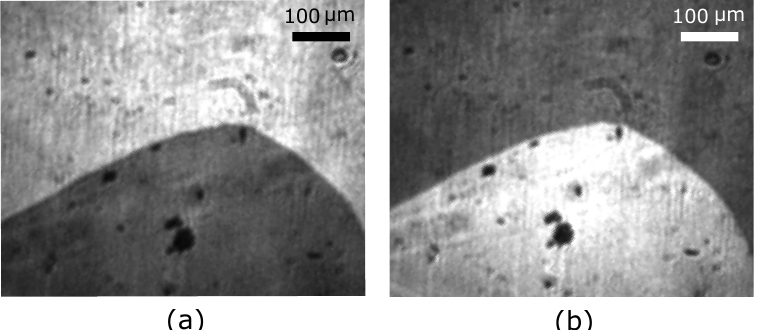
Figure 2. SHG images at room temperature of a z -oriented Cr 2 O 3 bulk crystal prior to the deposition of the Pt electrode.( a ) Exposure with circularly left-handed fundamental light; ( b ) Exposure with circularly right-handed fundamental light. Two antiferromagnetic domain states are clearly distinguishable and exhibit the expected reversal of contrast with reversal of the circular polarization